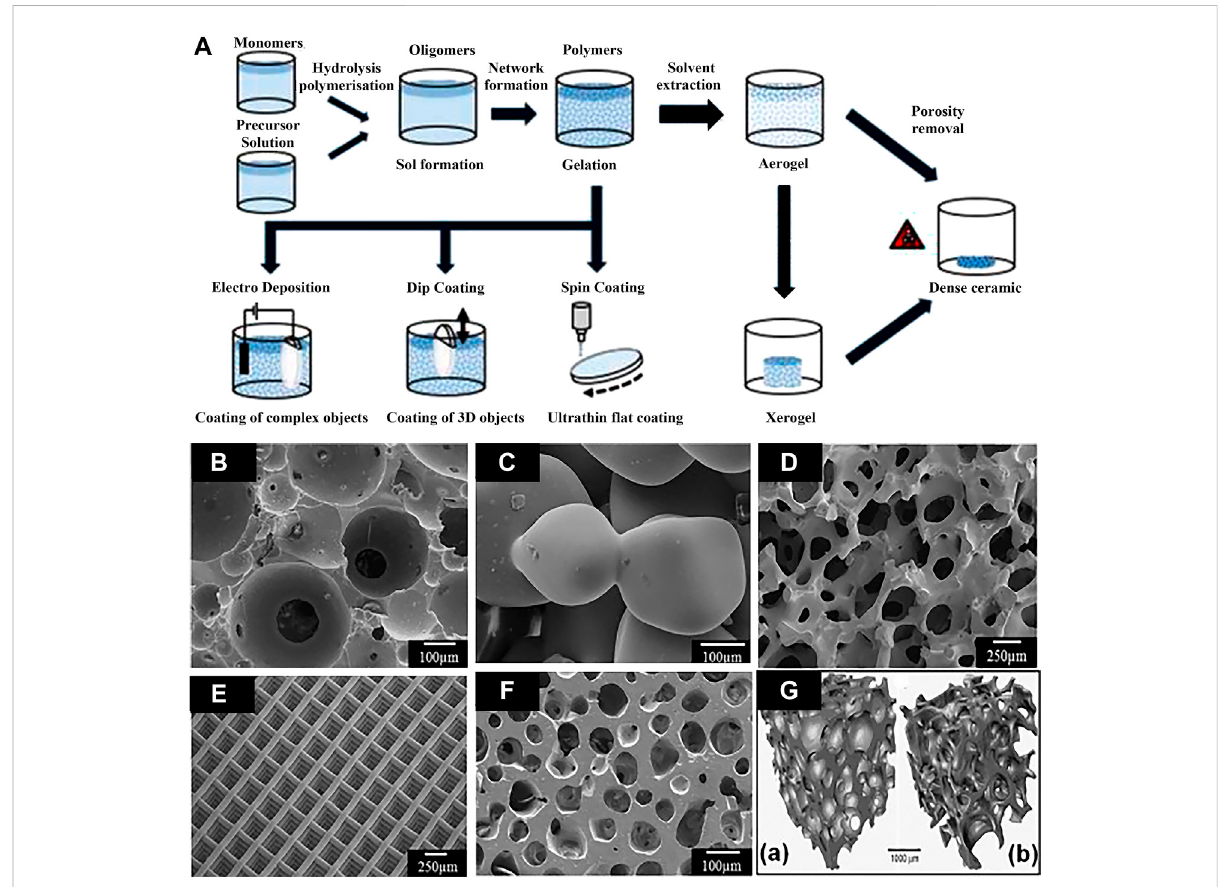
FIGURE 6 (A) Schematic illustration of preparation processes of the sol-gel coatings; (B – F) bioactive glass scaffolds with porous structure produced by sol-gel methods, and (G) micro-computed tomography image of typical scaffold and human trabecular bone. Reprinted with permission from reference (Owens et al., 2016),